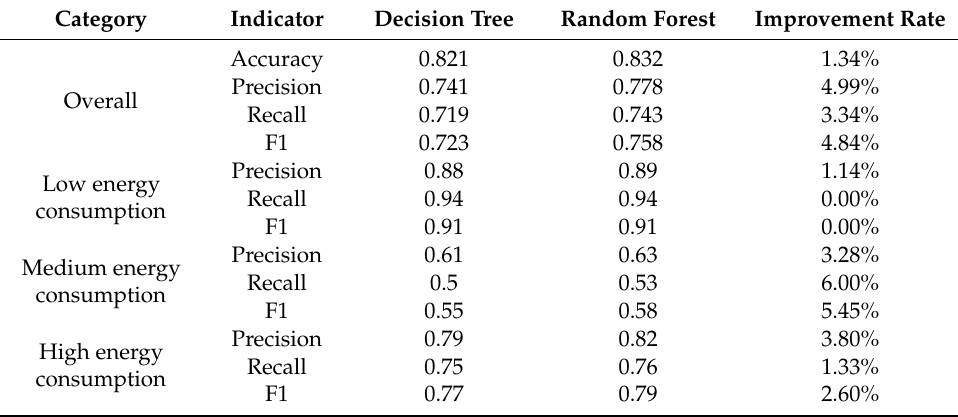
Table 6. Comparison between the optimal decision tree and random forest